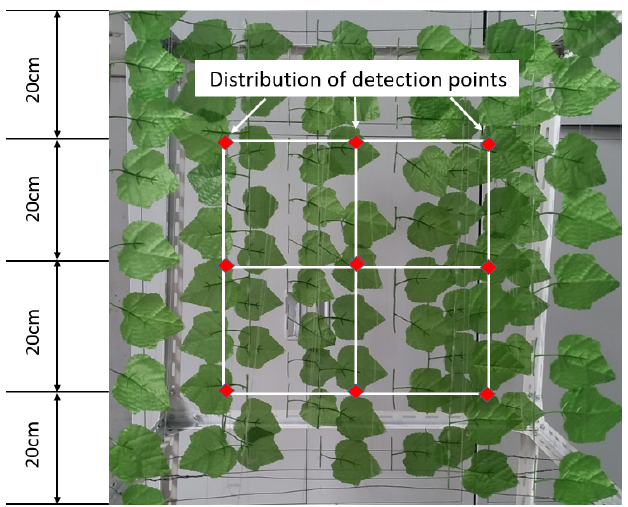
Figure 4. Distribution of detection points.